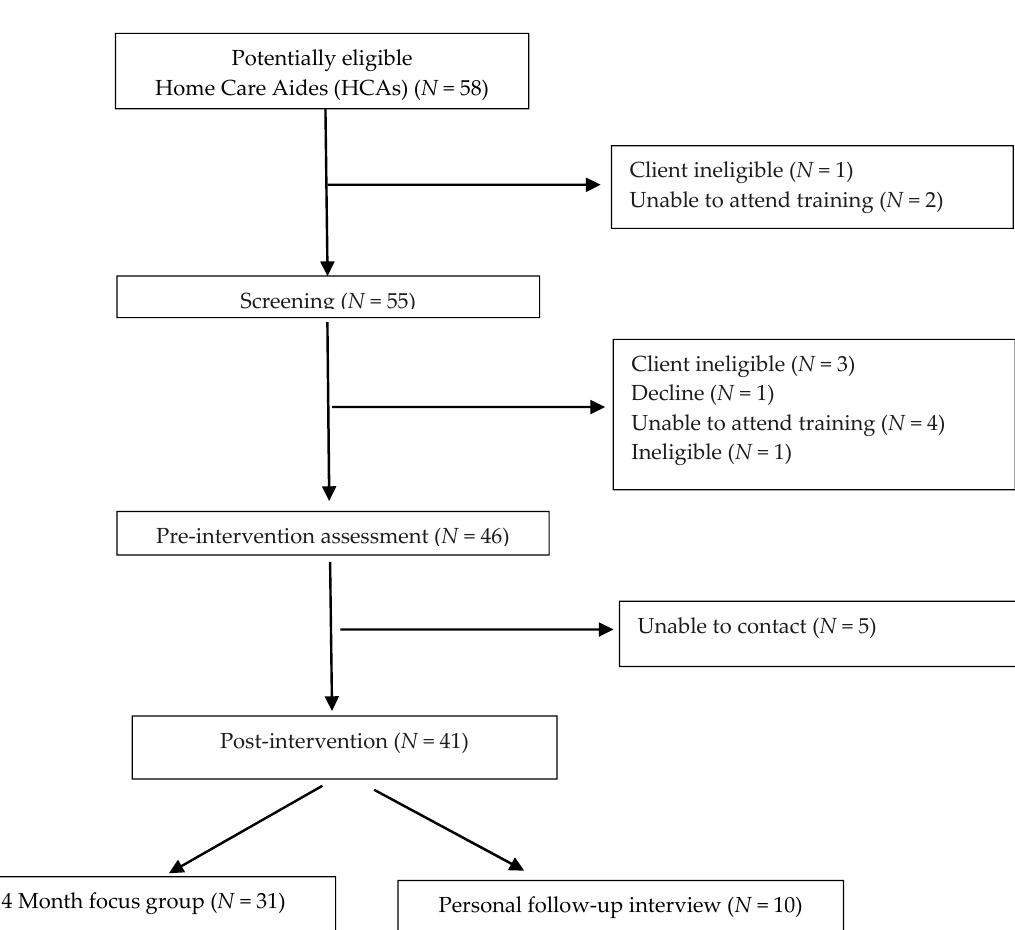
Figure A1. Flow diagram of home care aides recruitment and retention in Promoting Seniors’ Health with Home Care Aides: A Pilot.